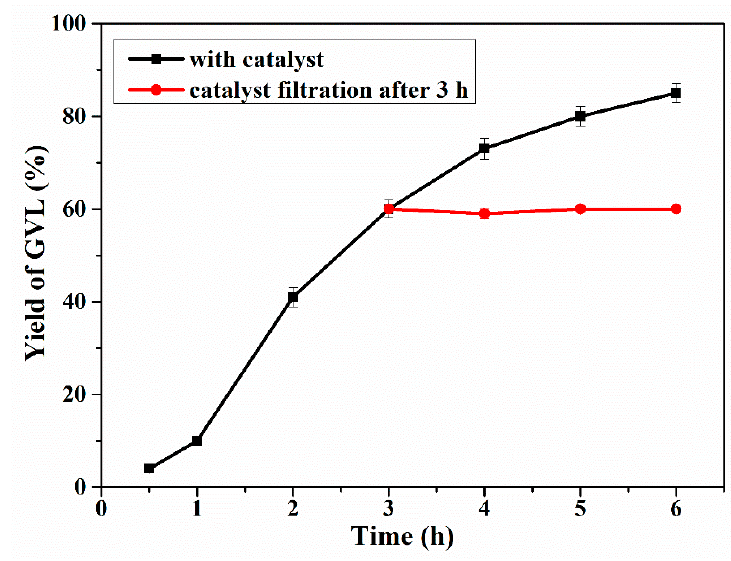
Figure 10. Hot filtration experimental results of the PPOA–Hf-1:1.5-catalyzed conversion of EL to GVL. Reaction conditions: EL, 1 mmol; PPOA–Hf-1:1.5, 72 mg; 2-propanol, 5 mL; and T, 160 °C.